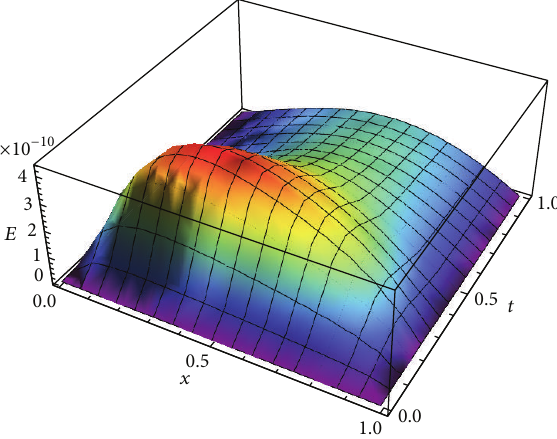
Figure 6: The absolute error of problem (40) where ] = 10 , 𝜇 = 0.1 , 𝑐 = 0.1 , 𝛼 = 𝛽 = 1/2 , and 𝑁 = 20